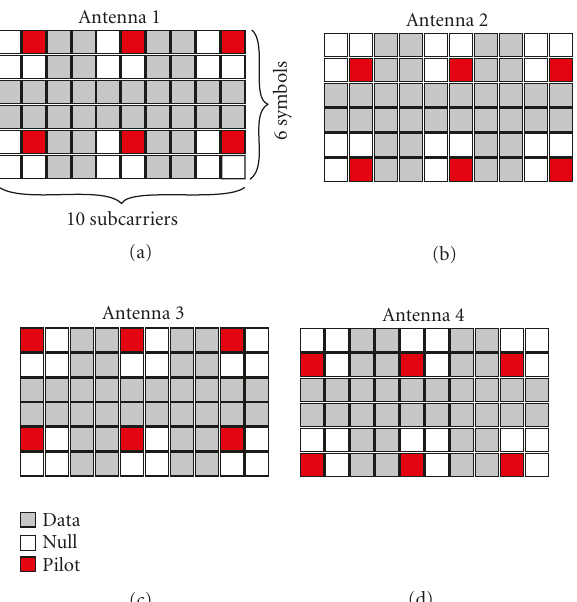
Figure 2: Example for placing orthogonal pilots over antenna-specific OFDM subframes, N T = 4, N (1) p = N (2) p = N (3) p = N (4) p = 6, and N d =